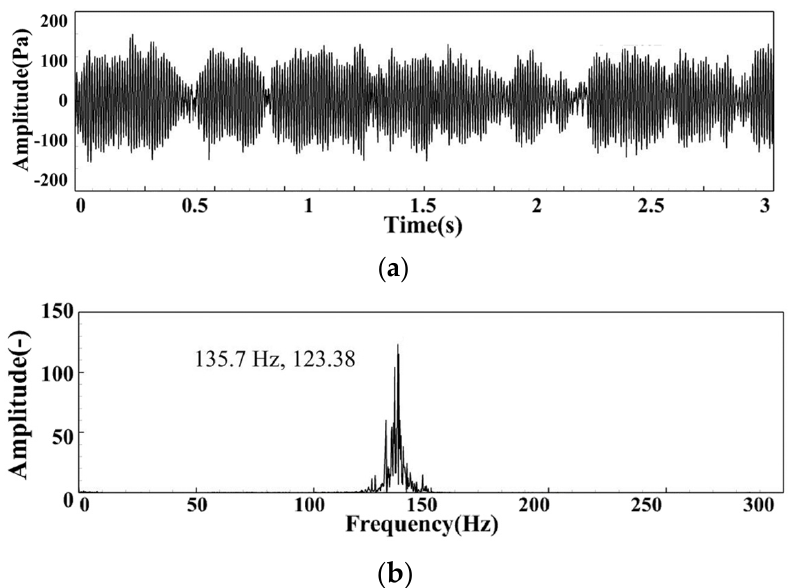
Figure 5. DP signal and spectrum within 2 s under MA02 operating condition: ( a ) DP signal of MA02; ( b ) Spectrum of DP signal.